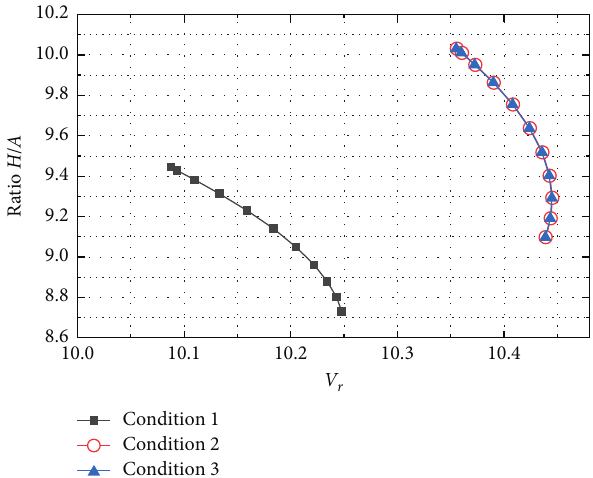
Figure 14: Curves of reduced wind speed and vertical-torsional ratio in three